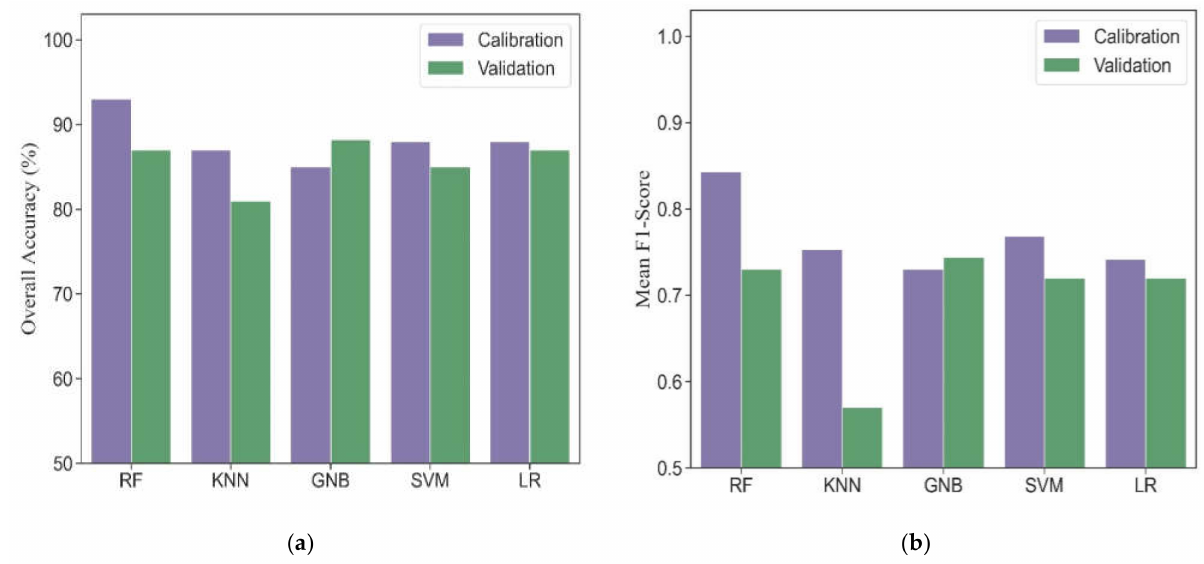
Figure 5. The overall accuracies ( a ) and mean F1-scores ( b ) in different machine learning models for phenological detection in calibration and validation